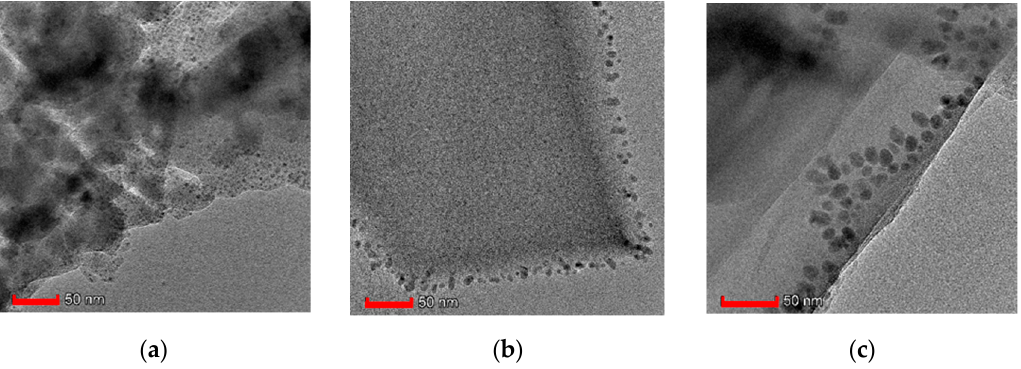
Figure 2. High resolution transmission electron microscopy (HRTEM) images of ( a ) HKUST-1, ( b ) HKUST-1@GO-1 and ( c ) HKUST-1@GO-2.5. The scalebar is 50 nm.